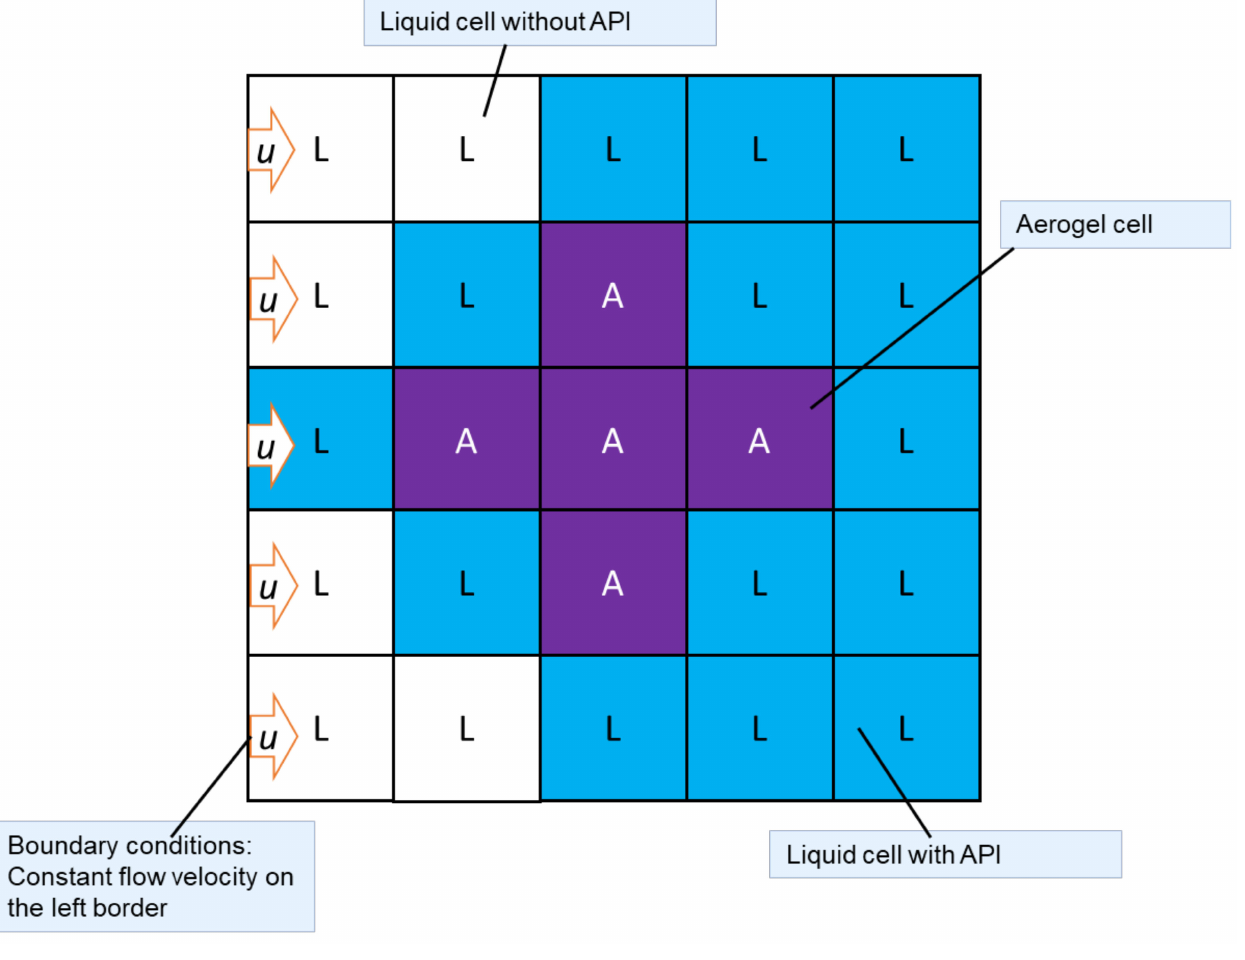
Figure 10. An example of a system configuration after several time